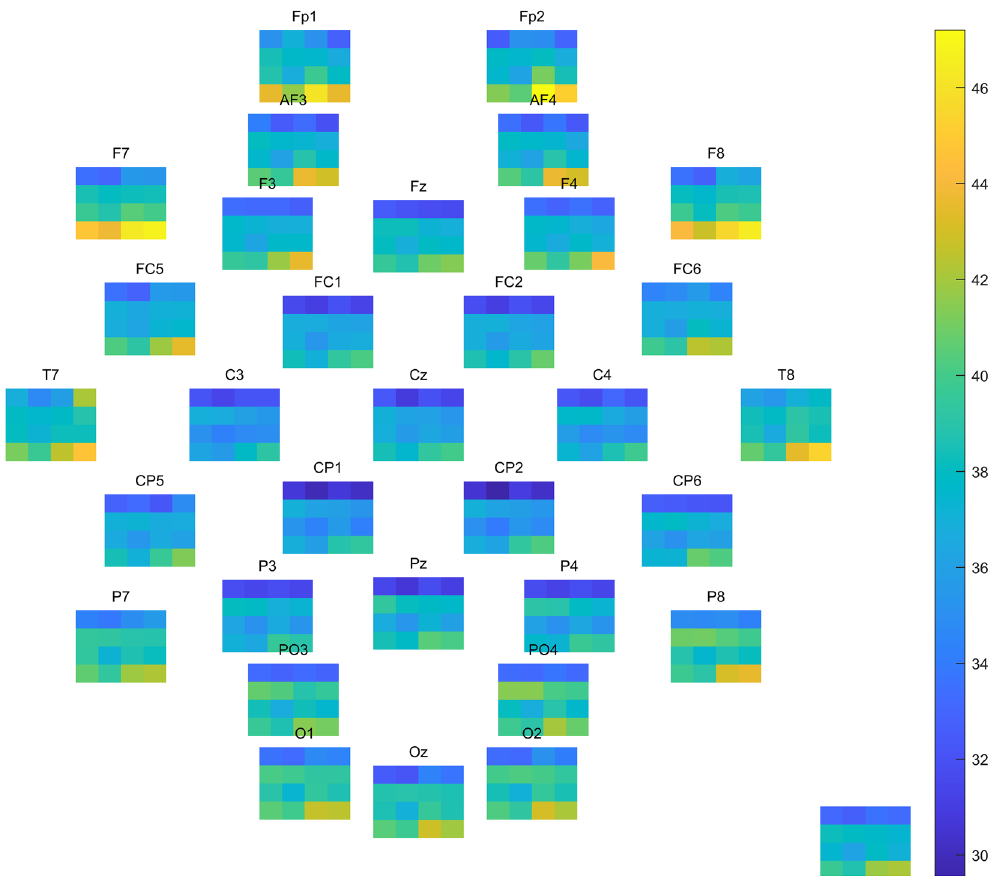
Figure 2. Average power in dB for each electrode (placed according to their head map location, title is the electrode name) and the mean of all electrodes (bottom right) for all participants. Each subfigure has the four exposures on the x-axis (air baseline, air 608 kPa, heliox baseline, heliox 608 kPa) and four frequency bands on the y-axis (bottom to top: delta (1–4 Hz), theta (4–8 Hz), alpha (8–14 Hz) and beta (14–30